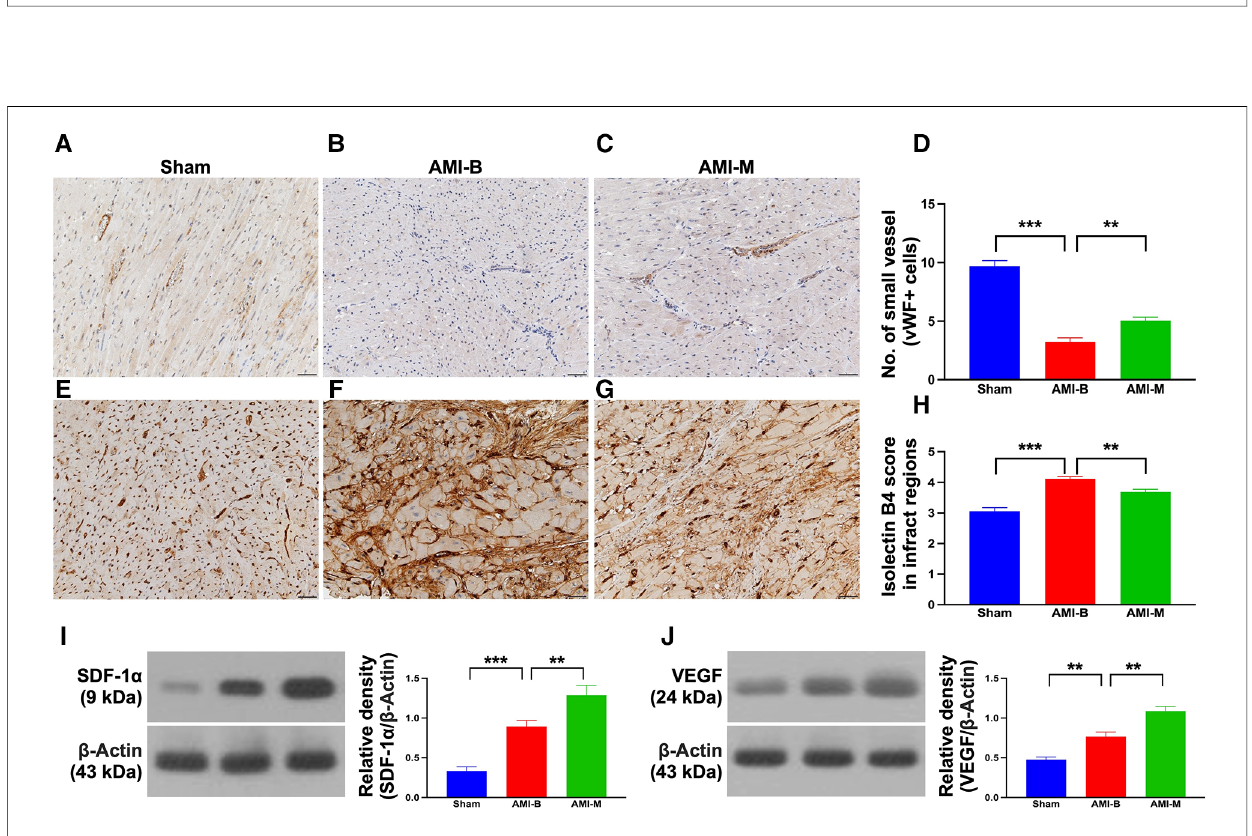
FIGURE 6 Endothelial cell marker, vascular niche, and protein expressions of angiogenesis biomarkers in LV infarct myocardium 5 months after AMI induction. ( A – C ) The microscopic fi nding (200×) of IHC stain for identi fi cation of cellular expression of vWF in the small vessels (gray color). ( D ) Analytical result of number of small vessels with positively-stained vWF; *** p <0.0001; ** p <0.001. ( E – G ) The microscopic fi nding (200×) of IHC stain for identi fi cation of cellular expression of isolectin-B4 in infarct myocardium (gray color). ( H ) Analytical result expression of IHC-stained intensity score of isolectin-B4; *** p < 0.0001; ** p <0.001. All scale bars in lower right corner represent 50 µm. ( I ) Protein expression of SDF-1 α ; *** p <0.0001; ** p <0.001. ( J ) Protein expression of VEGF; *** p <0.0001; ** p <0.001. Sham (group 1), sham-operated control; AMI-B (group 2), AMI+buffer; AMI-M (group 3), AMI+ hBMMSC; AMI, acute myocardial infarction; hBMMSCs, human bone marrow-derived mesenchymal stem cells; LV, left ventricular; IHC, immunohistochemical; vWF, von Willebrand factor; SDF, stromal cell-derived factor; VEGF, vascular endothelial growth